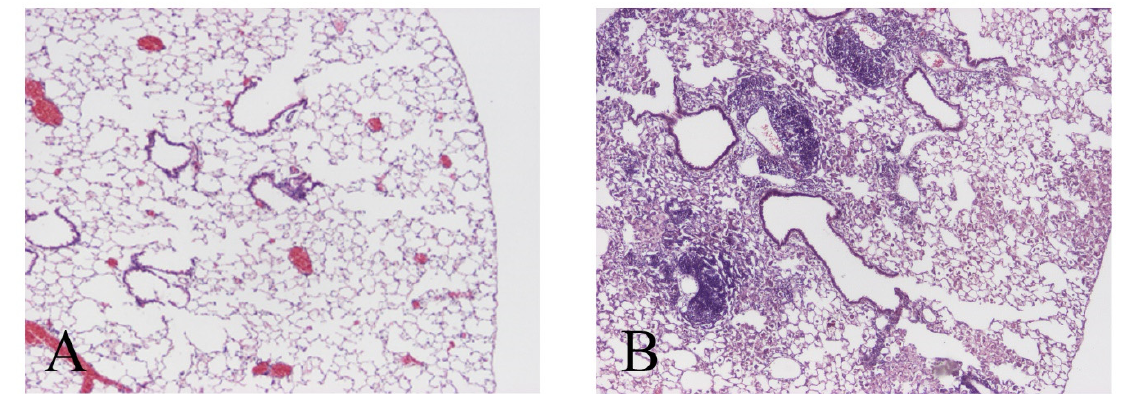
Figure 6. Histology of lungs from mice 60 days after M. avium administration. ( A ) Wild mice (C57BL/6) administered M. avium followed by inhalation of vehicle (1% DMSO in saline). ( B ) Wild mice administered M. avium followed by inhalation of Z-VAD FMK (1 mg/mL). The marked inflammatory cell infiltrate in the lungs from wild mice after Z-VAD FMK inhalation was noted. Original magnification ×40. Three experiments were done and demonstrated similar results.